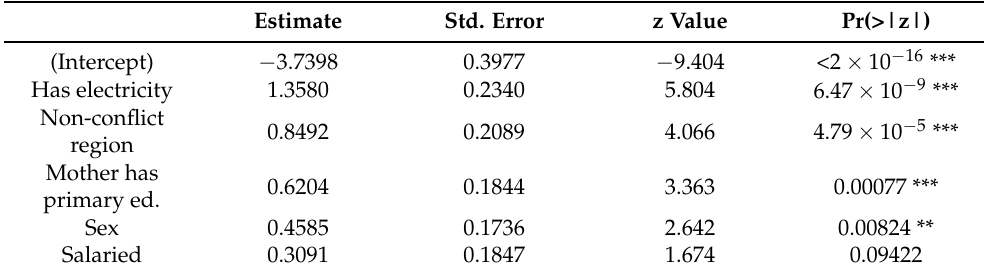
Table 7. Regression coefficients for model in which conflict regions and no-conflict regions are coded as 0 and 1,